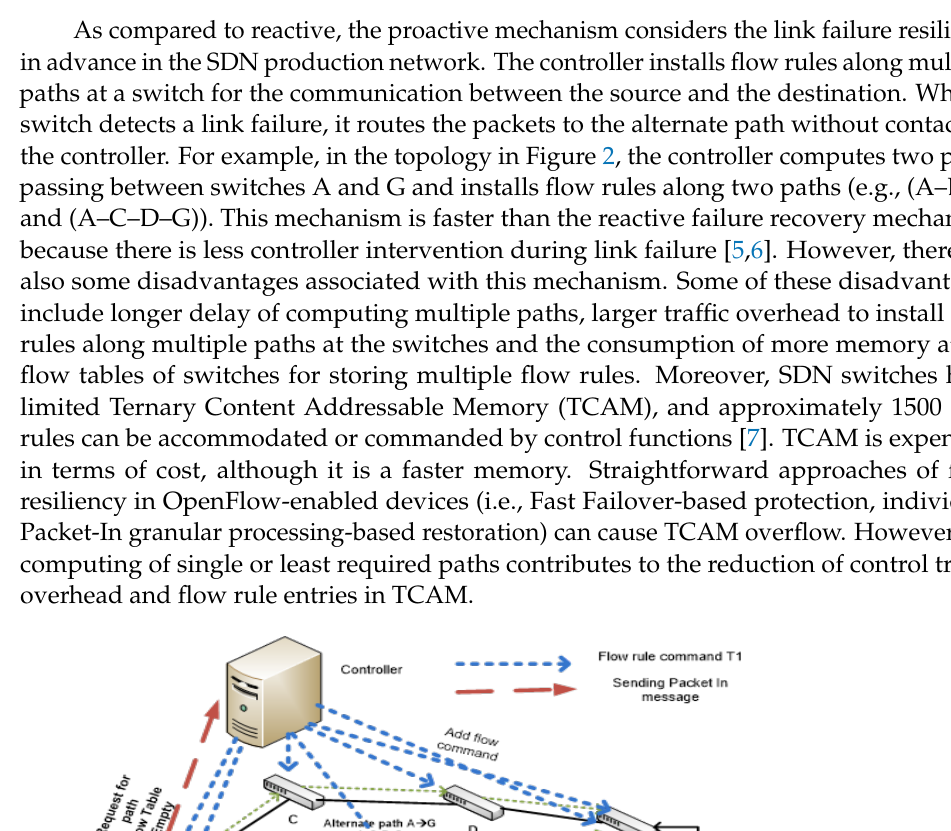
Figure 1. Reactive alternate flow rule installation in case of link failure.